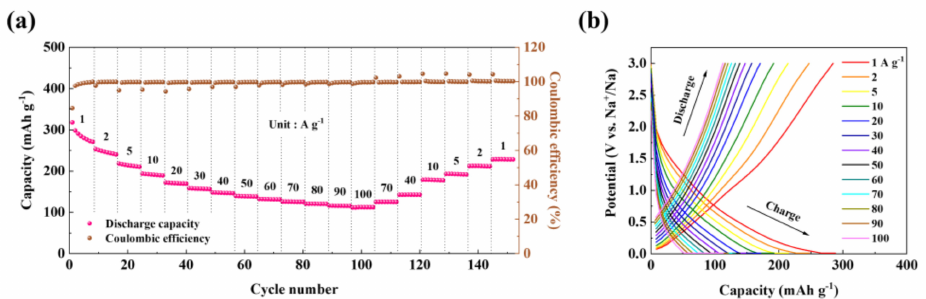
( a ) Rate capability at various current densities ranging from 1 to 100 A g − 1 ; ( b ) charge/discharge profiles at different rates.